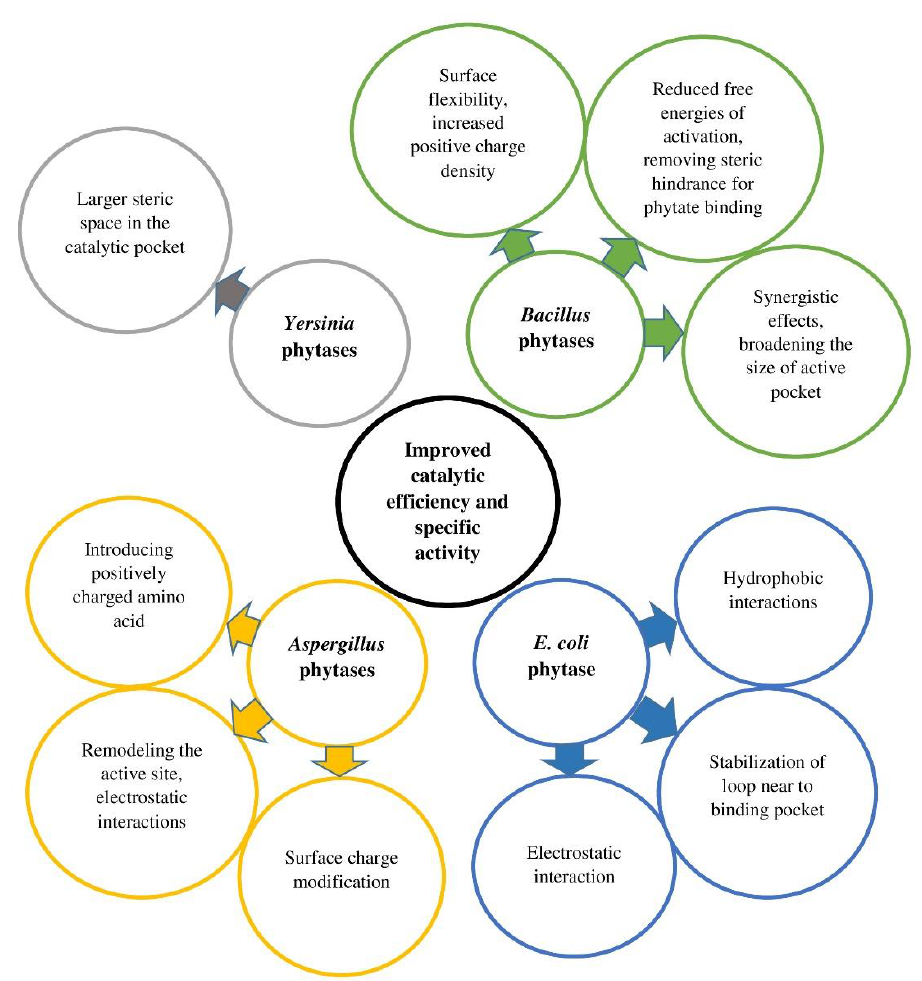
Figure 11. Contributing factors in improved catalytic efficiency and specific activity of phytases. Table 4. Improvements of catalytic efficiency and specific activity of various microbial phytases.